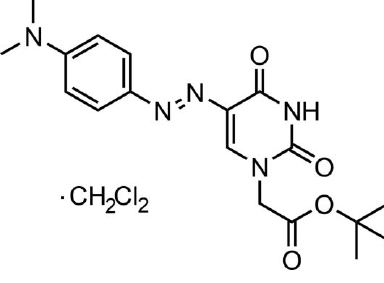
Data collection Nonius KappaCCD diffractometer Absorption correction: multi-scan ( SADABS ; Bruker, 2008) T min = 0.689, T max = 0.746